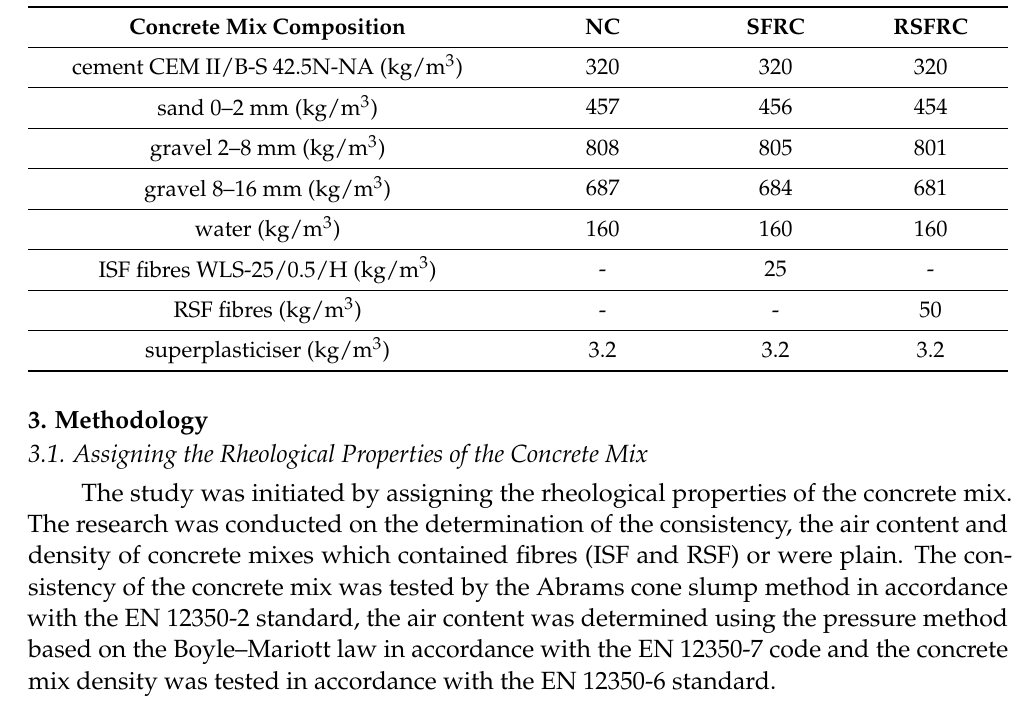
Table 3. Composition of concrete mixes without fibres (NC), with ISF fibres (SFRC), and with RSF fibres